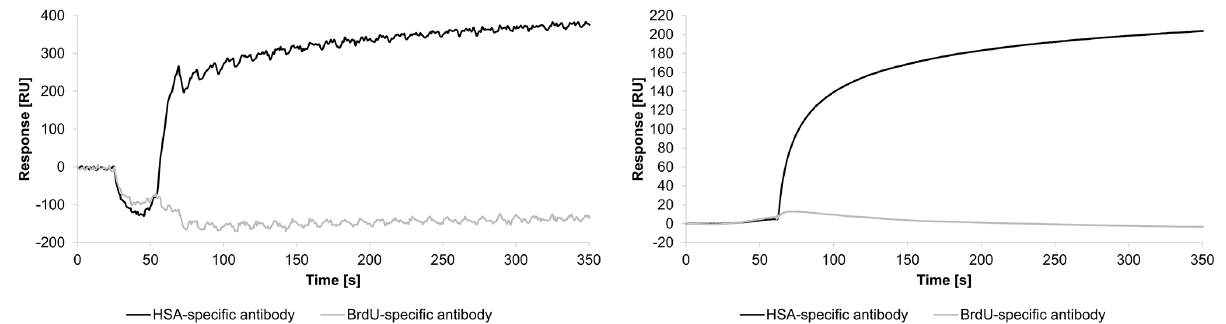
Figure 3. Sensorgrams showing the interaction of 1.5µM HSA with immobilized HSA-specific antibodies and BrdU-specific antibodies. The left and right panels depict the signals obtained using the li SPR and Biacore T100 systems, respectively.